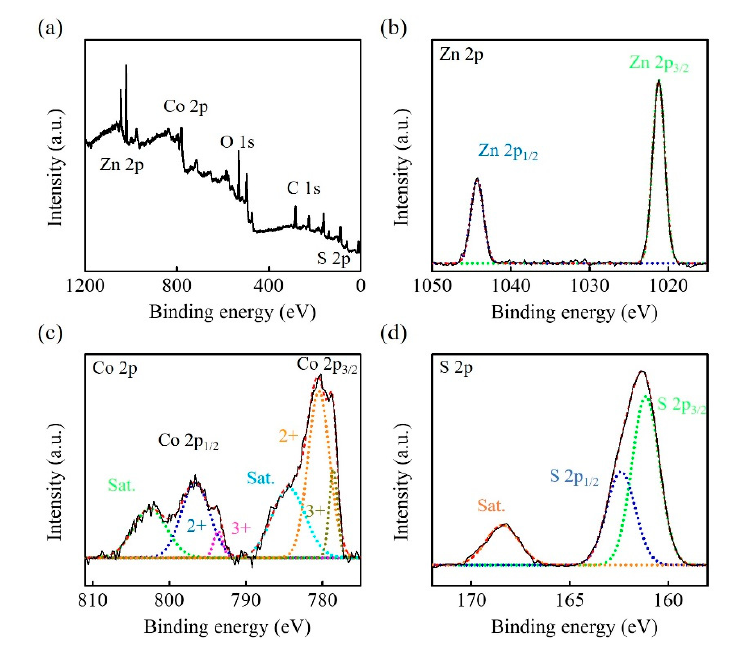
Figure 3. XPS spectra of Zn-Co-S BHS ( a ) full scan, ( b ) Zn 2p, ( c ) Co 2p, and ( d ) S 2p.